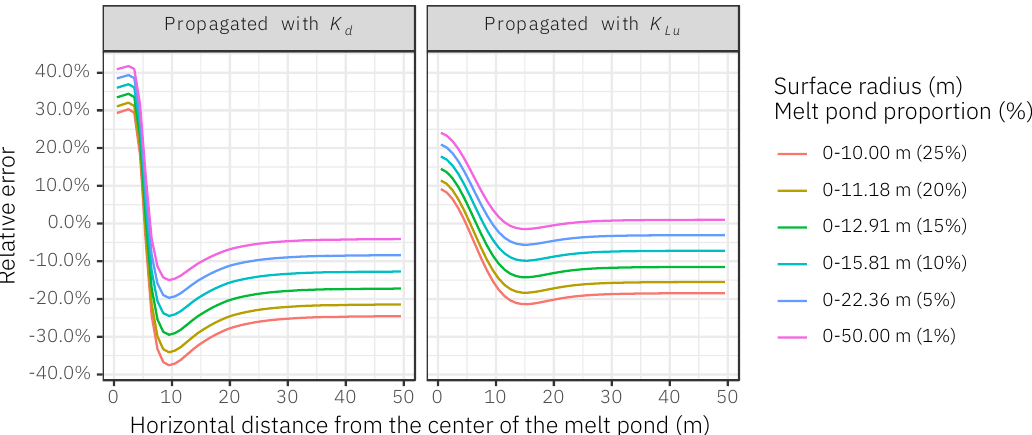
Figure 11. Relative errors of the predictions calculated as the relative differences between the depth integral of the reference and predicted irradiance profiles.